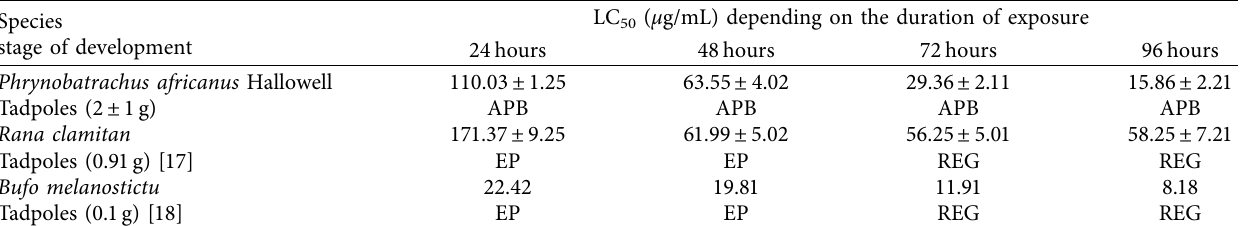
50 ) of aqueous extract Antrocaryon klaineanum for frog tadpoles ( Phrynobatrachus africanus Hallowell).